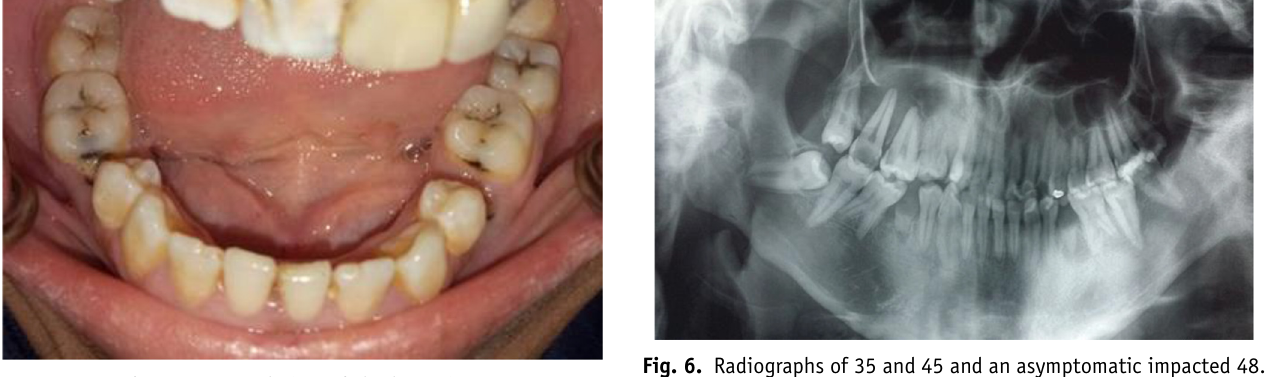
Fig. 5. Intraoral view of the